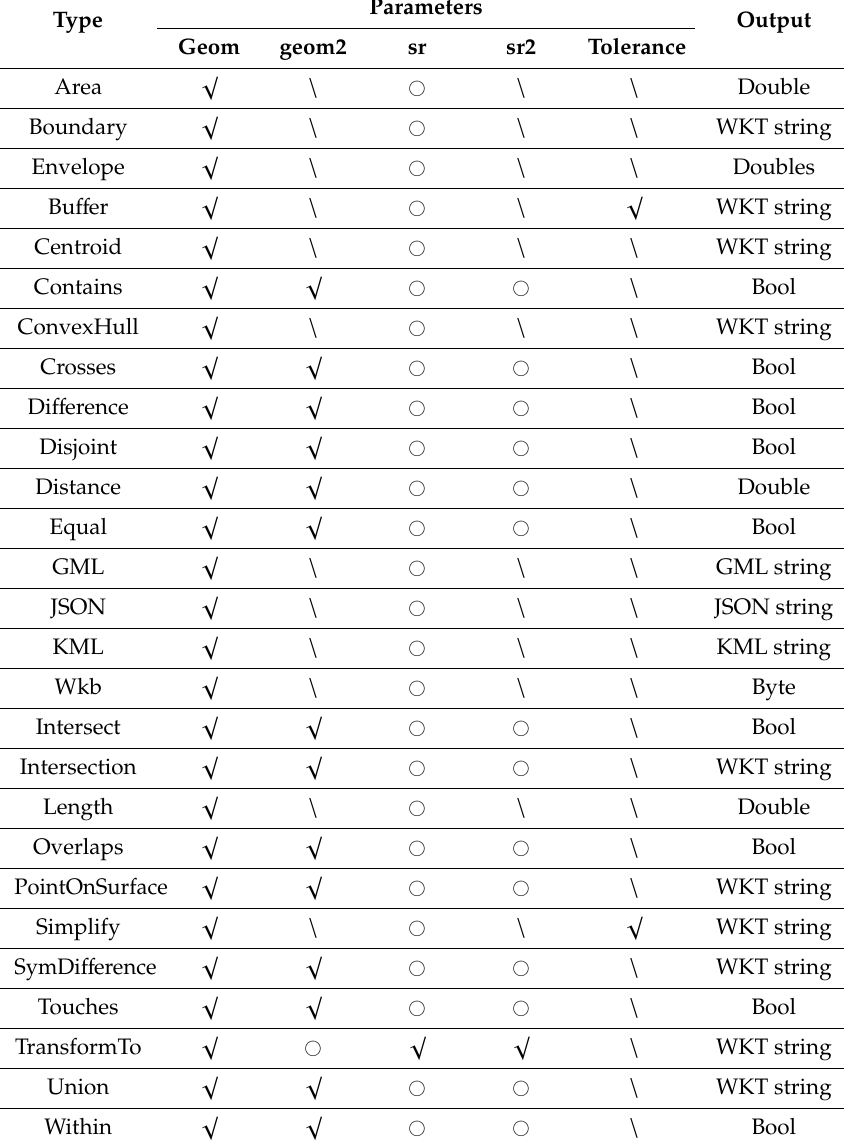
Table 5. Supported geometric spatial analysis